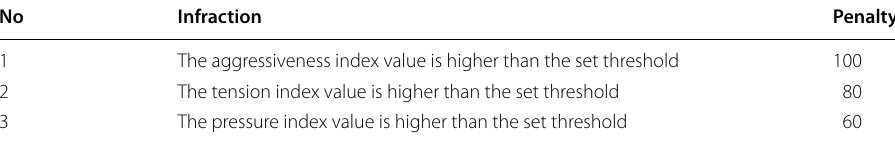
Table 9 Potential emotional analysis penalty standard